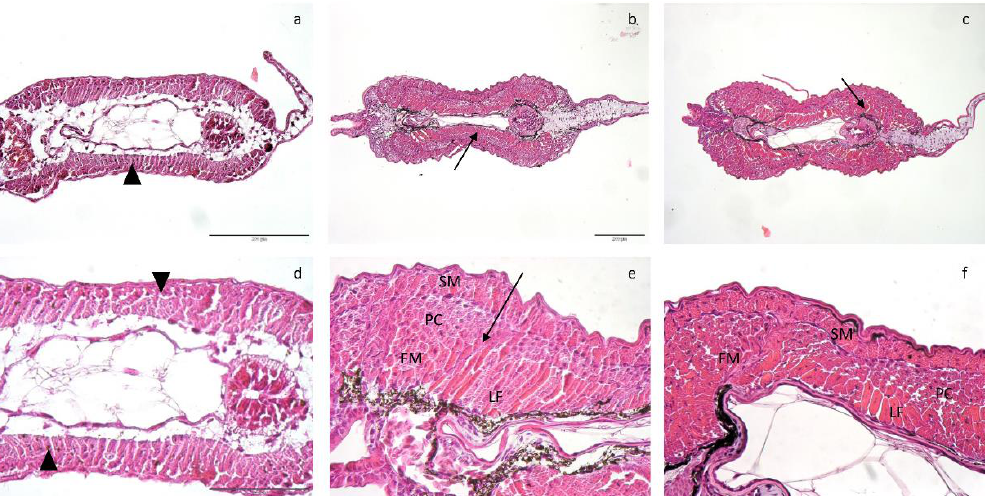
Figure 3. HE staining representative figures for: ( a , d ) hatching; ( b , e ) schooling; and ( c , f ) yolk-sac full absorption, at BB1. FM, fast muscle; SM, slow muscle; monolayer, arrowheads; multilayers, arrows; LF, lamella-shaped fibre; PC, polygonal cells. ( a ) has the scale bas as indicated in the figure itself: 200 µm; ( c ) has the same scale bar as located in ( b ): 200 µm. ( e , f ) have the same scale bas as indicated in ( d ): 100 µm.